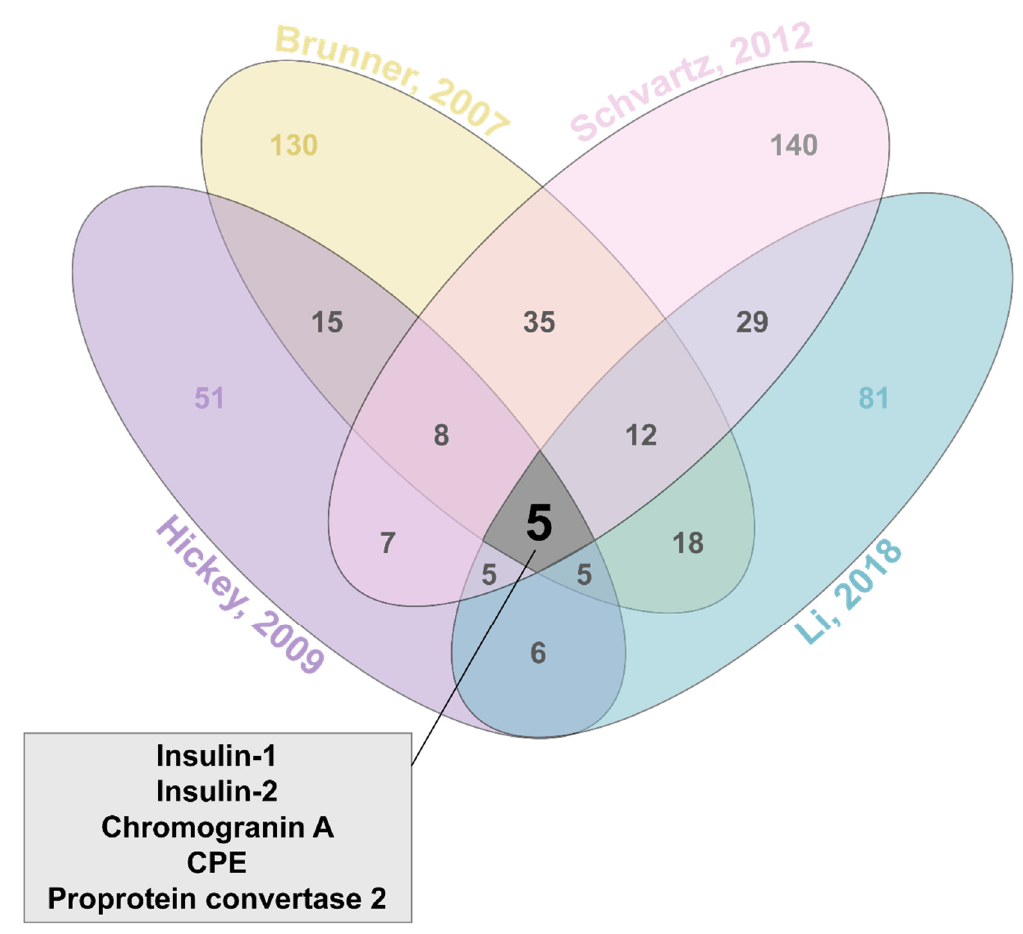
Figure 4. Venn diagram of overlapping proteins identified across the 4 ISG proteomes. Total of 5 proteins identified (box) in all proteomic analyses. Data collated from Brunner et al., 2007, Hickey et al., 2009, Schvartz et al., 2012 and Li et al., 2018.